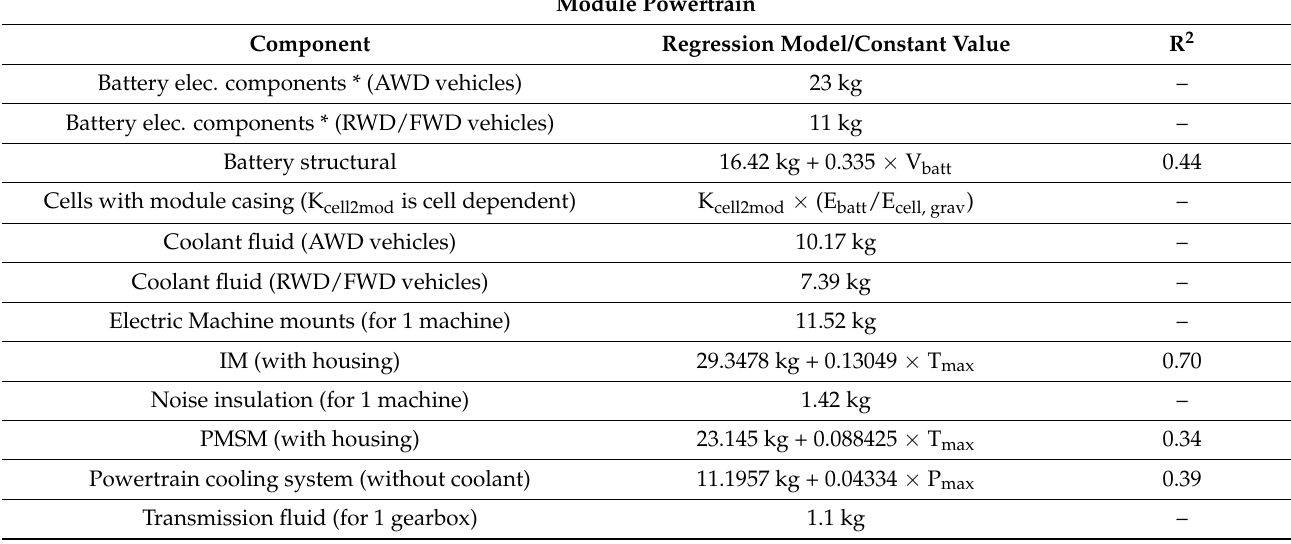
Table A5. Empirical models for the Powertrain module. The transmission mass is not calculated empirically but estimated with the semi-physical model described in [5]. The cell mass estimation is semi-physical and bases on the results of the package